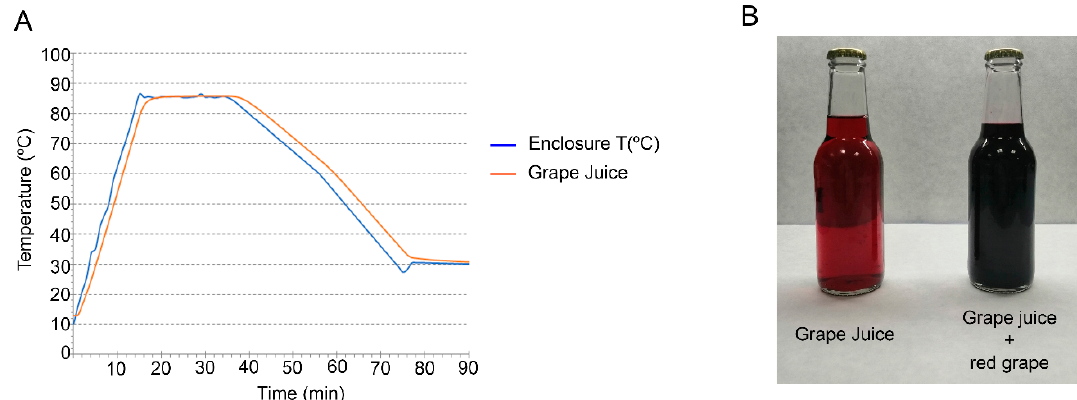
Figure 1. Temperatures in pasteurization process ( A ). Photograph of experimental bottles containing grape juice and grape juice with red grape polyphenols ( B ).